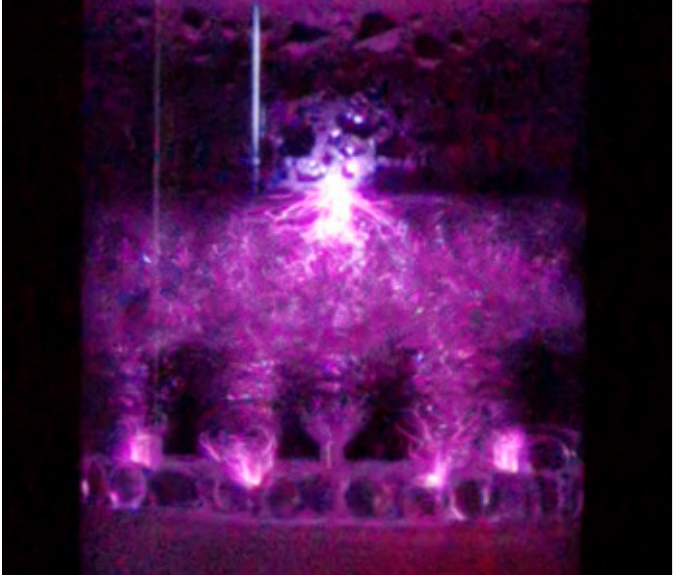
Figure 2. Discharge image of the NPG-LD under 24 kV of pulse peak voltage with a 150 Hz Pulse repetition